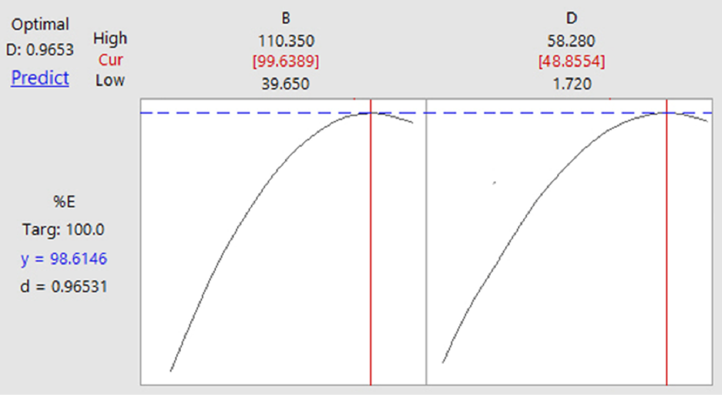
Figure 6. Optimization plot for the extraction of Cd(II) ions; B: Aliquat 336 (mM); D: EDTA (mM). To maximize the extraction of Cd(II) from the mixture of Cd(II)-Cu(II) (100 mg/L) synthetic solution, experimental runs were conducted under optimum conditions, whereby, 10 min of mixing time, 99.6 mM Aliquat 336, 50 mM TBP, 48.86 mM EDTA, O:A = 1 and 150 rpm of mixing speed using toluene as diluent. The composite desirability of 0.96531 (~1.00) was obtained from Minitab software as listed in Table 7, with a small deviation (2.76%) of the experimental (95.89%) from the predicted (98.61%) Cd(II) extraction % revealed that the regression model in Equation (4) was satisfied. Table 7. Model validation with optimum operating conditions for the extraction of Cd(II). Composite Desirability